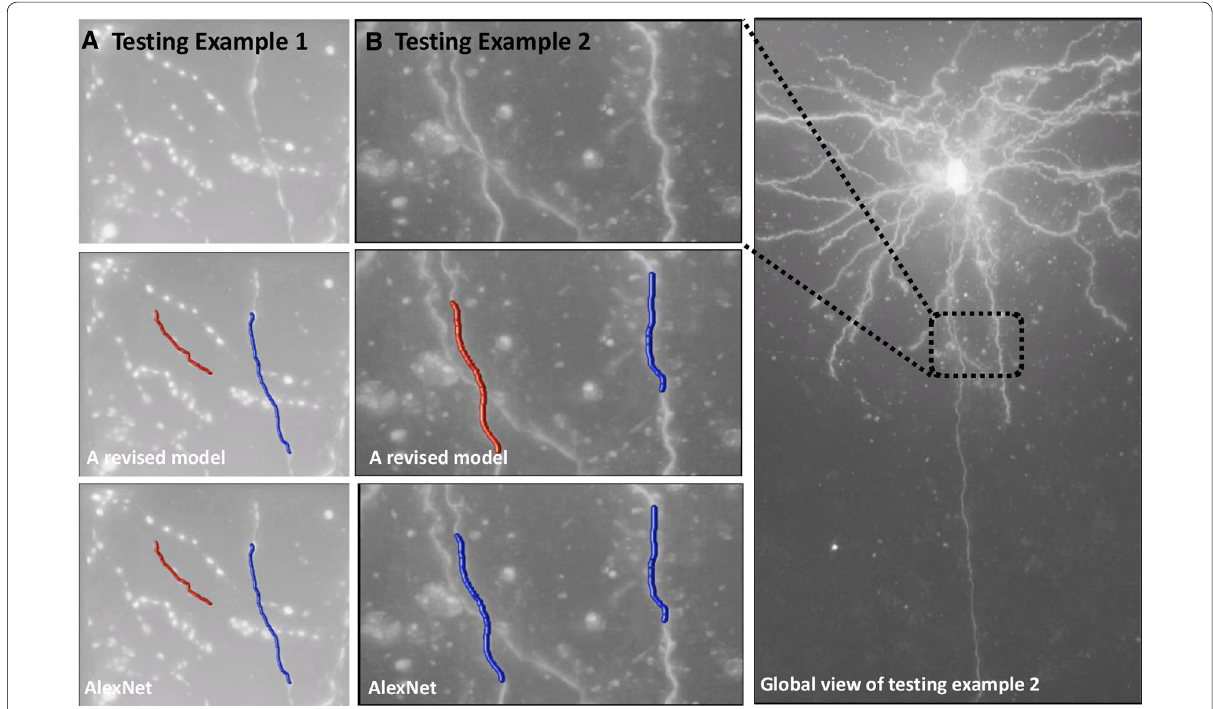
Fig. 8 Comparison of dendrite and axon classification using AlexNet and a revised model. ( a ) Axons are discrete, and dendrites are continuous. ( b ) Both axons and dendrites are continuous. The left segment is extracted from a long axon. The right segment is extracted from a local dendrite. Red color indicates the axon, and blue color indicates the dendrite in ( a ) and ( b ). Note that all these 3D segments are manually annotated using Virtual Finger technology [7, 9]; neurite types are automatically annotated by the proposed module